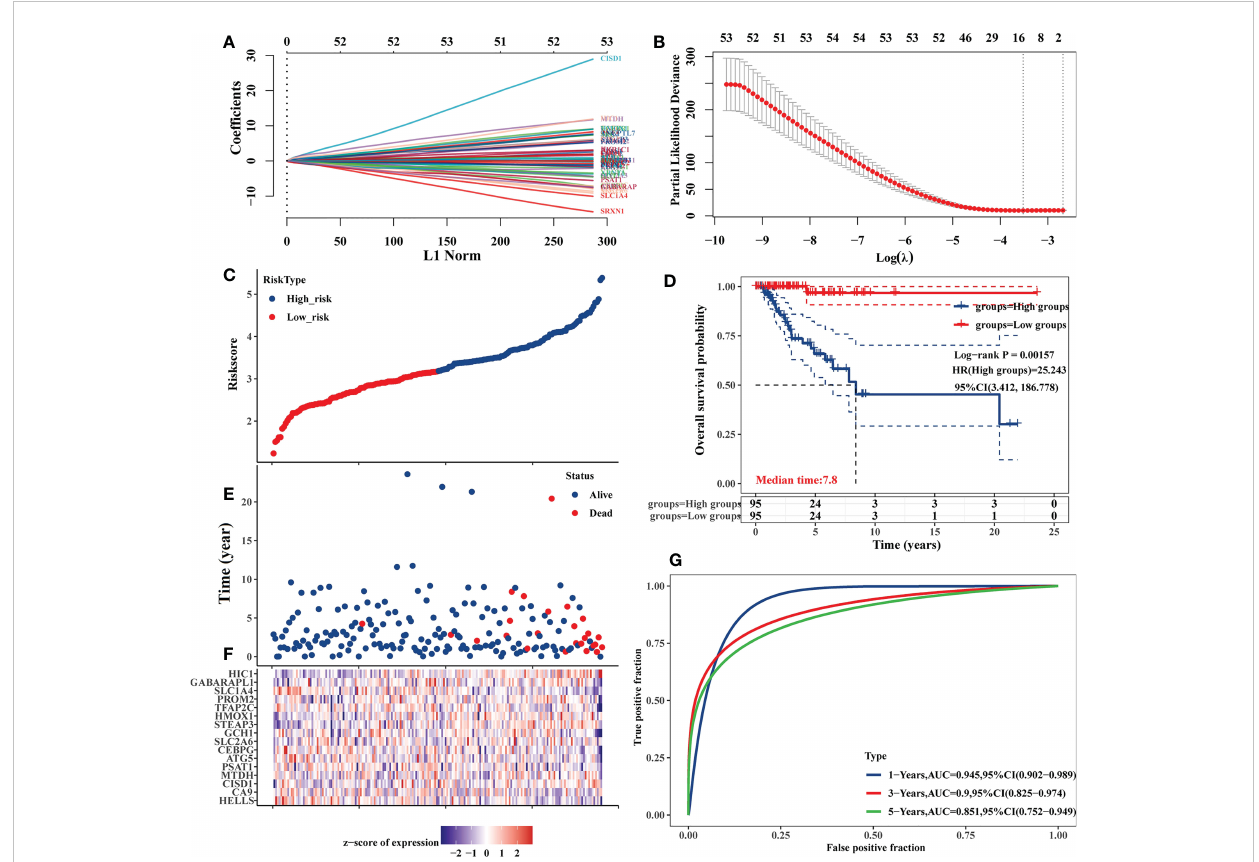
FIGURE 4 Development of an 87 DE-FRG-based prognostic risk signature in the TCGA-TNBC cohort. (A) LASSO coef fi cient pro fi les for 87 DE-FRGs. (B) LASSO regression analyses with 10-fold cross-validation yielded 16 prognostic DE-FRGs based on a minimum l value. (C, E) OS distributions, OS status, and risk scores for patients in the TCGA-TNBC cohort. (D) Kaplan-Meier curves corresponding to the OS of TCGA-TNBC patients strati fi ed into low- and high-risk groups. (F) Z-scores corresponding to the expression of the 16 prognostic DE-FRGs included in the established risk signature. (G) AUC values for time-dependent ROC curves were employed to assess the predictive utility of prognostic signature-derived risk